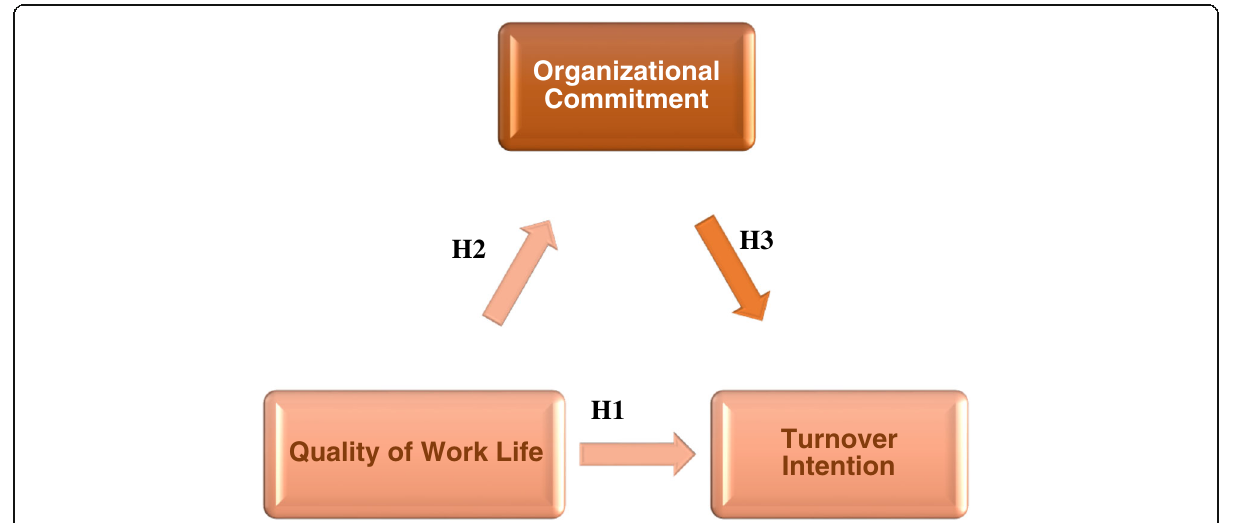
Fig. 1 The model clarifying the hypothesis of